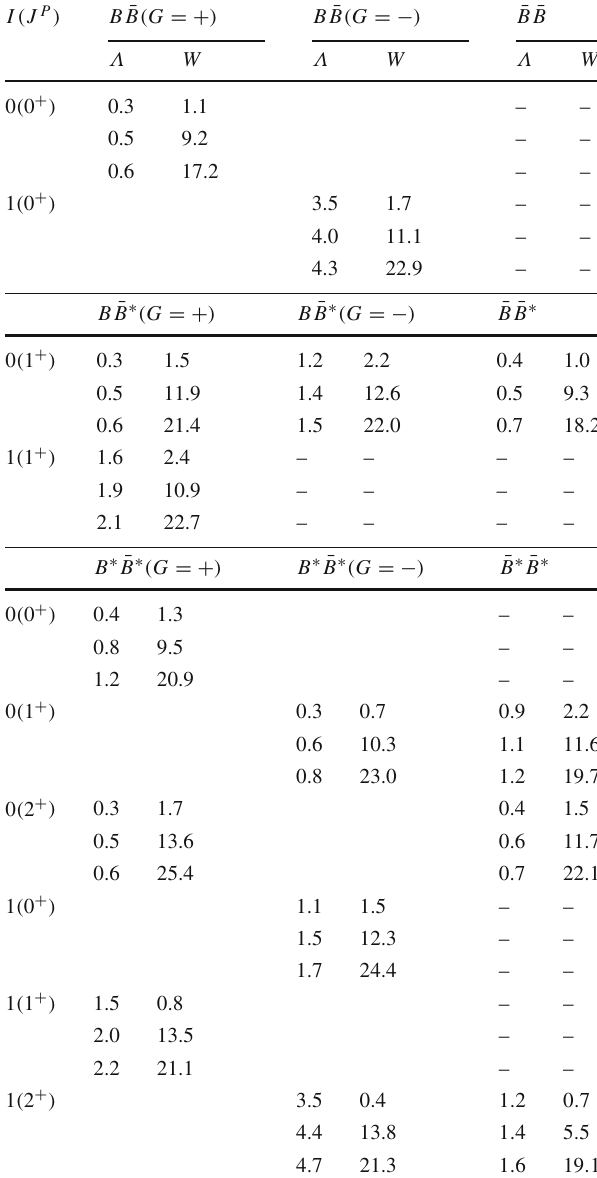
Table 3 The binding energy of the bound states from the B ( ∗ ) ¯ B ( ∗ ) and ¯ B ( ∗ ) ¯ B ( ∗ ) interactions with some selected values of cutoff Λ . Other notations are the same as in Table